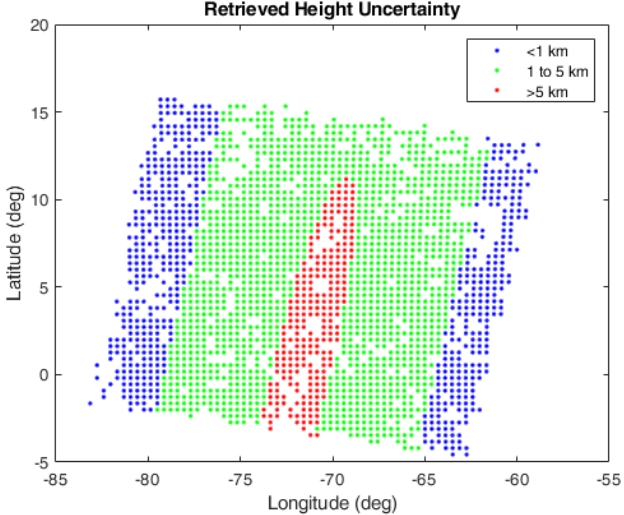
Figure 12. The geographic distribution of retrieved height uncertainty becomes very large when crossing the equator near the GOES subsatellite point, which is where the MODIS scan can be exactly parallel to that of GOES and height becomes unobservable. The case shown is MOD2019057.1510.061 (MODIS Band 31) paired with GOES-16 Full Disk Band 14.